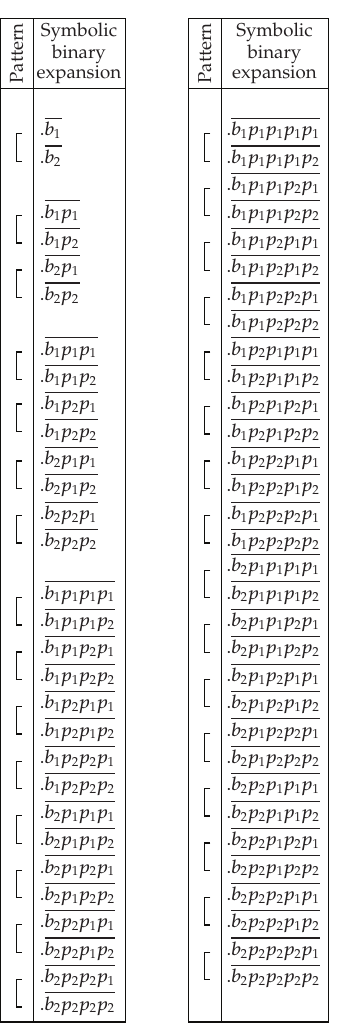
Figure 6: Coupling pattern of the external arguments of the BMSs up to fourth level in a canonical single- spiral